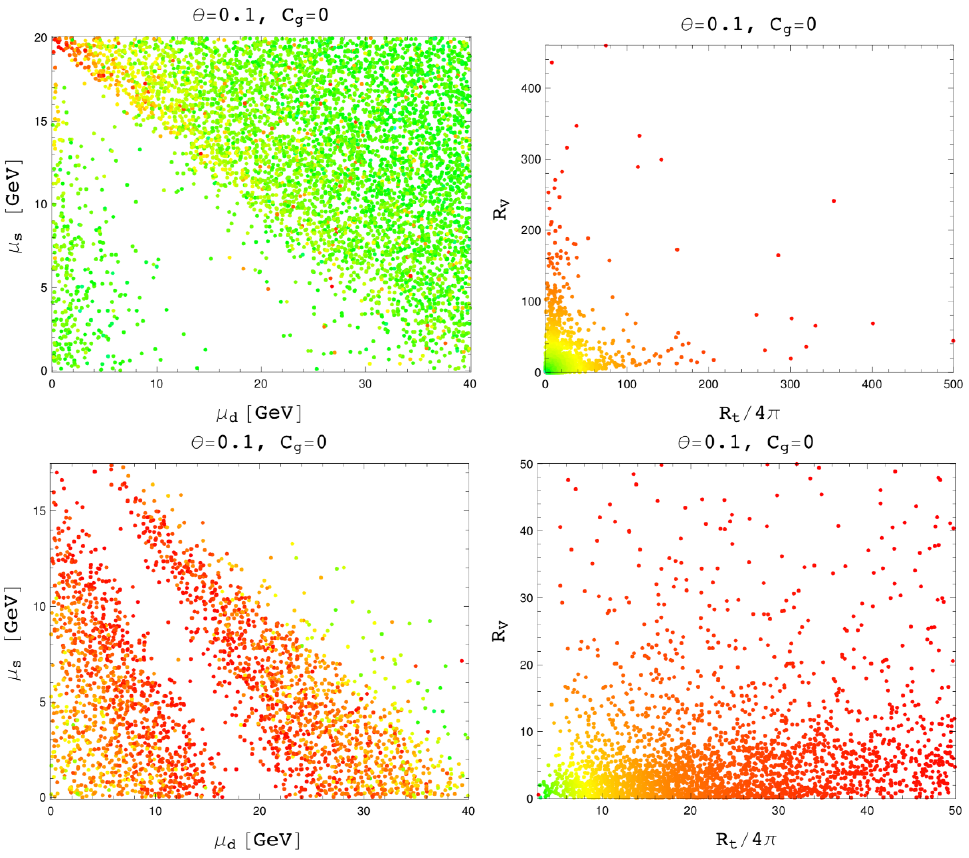
Figure 8 . Upper plots : points corresponding to choices of parameters that yield at least one tachyon in the spectrum (left), with the corresponding values of R V and R t = (4 (cid:25) ) (right). Lower plots : regions allowed by the no-tachyon requirement. The colours correspond to di(cid:11)erent values p of ( R t = (4 (cid:25) )) 2 + R 2 . We have also required that R V < 50 and R t = (4 (cid:25) ) < V